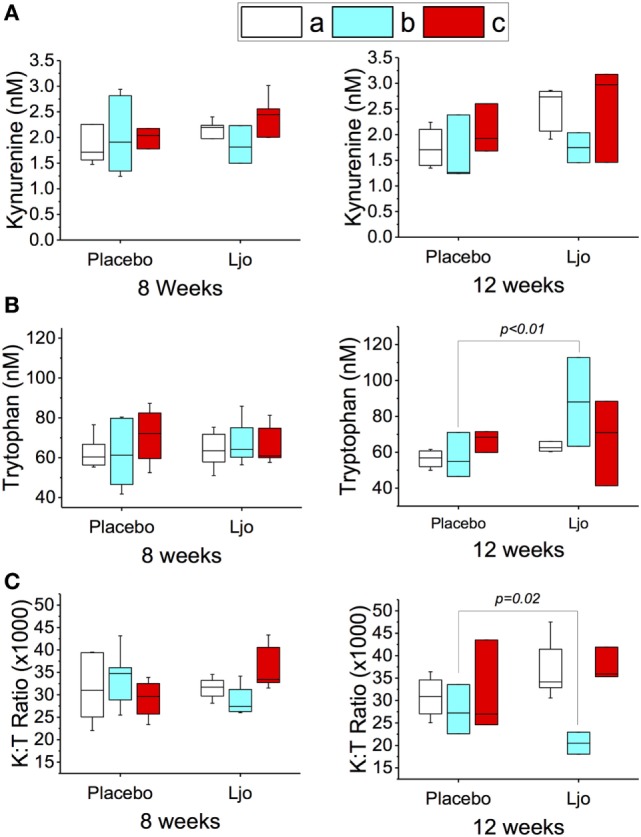
Peripheral tryptophan and kynurenine concentration in plasma of healthy subjects. The concentrations of kynurenine (A) and tryptophan (B) were determined by LC-HRMS/HRMS after 8 or 12 weeks in the placebo or L. johnsonii N6.2 (Ljo) treatment groups. Panel (C) is shown the kynurenine:tryptophan (K:T) ratio. The concentration of the metabolites shown has been normalized to the concentration found at time 0 for each subject. The results obtained were further stratified based on the number of LAB present as described in the Section “Results.” (a) High LAB; (b) low to high LAB, and (c) low LAB.